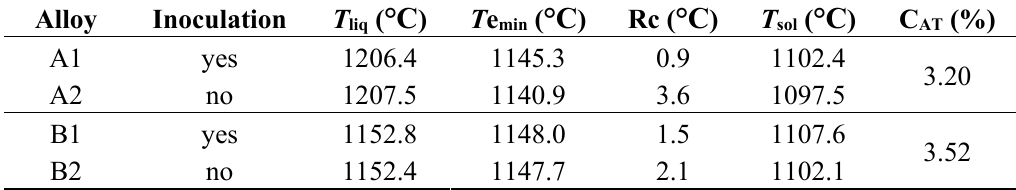
Figure 2. Cooling curves recorded from inoculated and non-inoculated samples. Table 2. Thermal analysis (TA) parameters obtained from the cooling curves plotted in Figure 2. Alloy Inoculation T ( °C liq